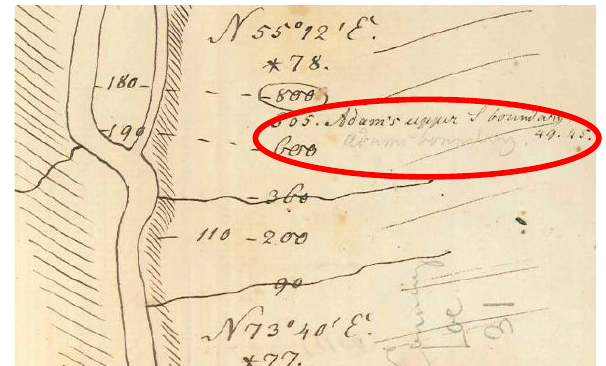
Figure 3: Field notes showing a property boundary (highlighted in